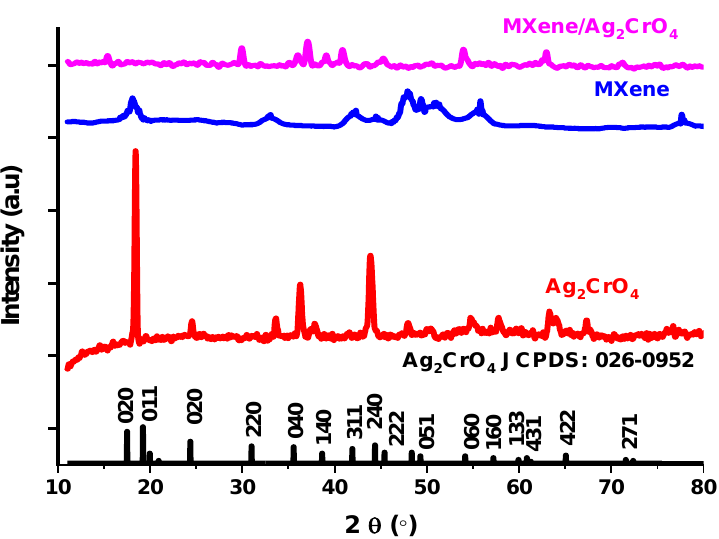
Figure 1. XRD patterns of Ag 2 CrO 4 , MXene and MXene/Ag 2 CrO 4 nanocomposite. From XRD data [38] the average crystallite size of MXene/Ag 2 CrO 4 nanocomposite was calculated by Debye-Scherrer Equation (3) given below.